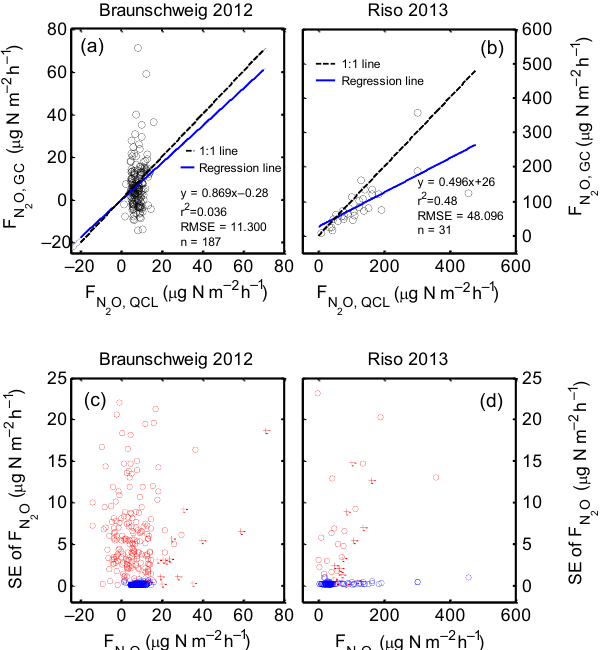
Figure 7. (a, b) GC vs. QCL-based N 2 O fluxes. (c, d) Relationships between standard errors (SEs) of N 2 O fluxes and the respective flux values. Blue markers indicate QCL data, which are all based on the 3min linear calculation method. Red markers indicate GC data, which are based on the full 60min data set. Crosses are plotted for GC data when all criteria for flux calculation using the exponential HMR model were met (see text for details); otherwise circles are plotted indicating the usage of a linear model for flux calculation.